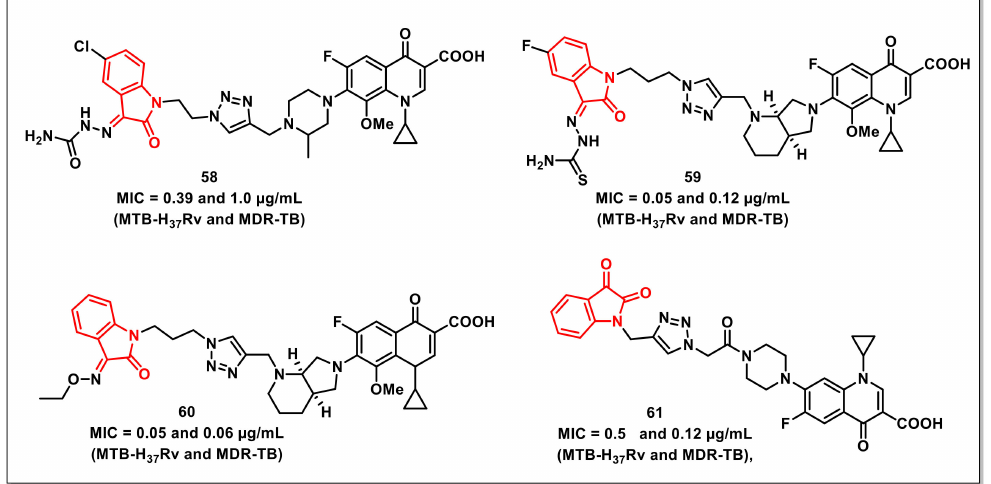
Figure 9. Ciprofloxacin and moxifloxacin-based isatins as